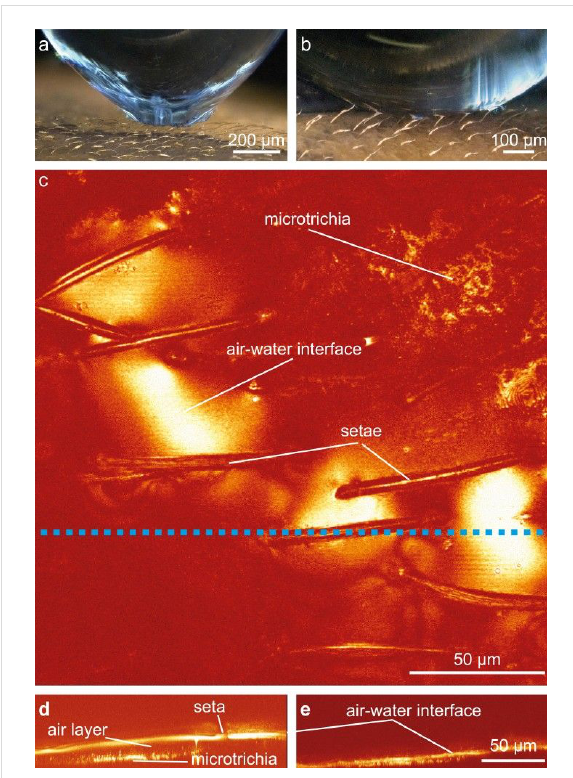
Figure 6: a) Image of a water droplet detaching from the surface of N. glauca . The deformation of the droplet indicates adhesion between the droplet and the pin-setae. This suggests that the pin-setae pene- trate the air–water interface and become wet. b) Water droplet lying on the club-setae of the superhydrophobic surface of N. glauca . c) Projec- tion through a stack of images using confocal laser scanning microsco- py. The picture shows the structure of the setae and the reflecting air layer in between the club-setae. d) Cross section through the image stack at the position of the blue line in (c) at ambient pressure. The shape of the air–water interface and the position of the club-setae and the microtrichia are visible. e) Cross section at the same position at a pressure of 180 mbar. The air layer is compressed and the air–water interface is lying on the microtrichia. The clubs are deflected towards the